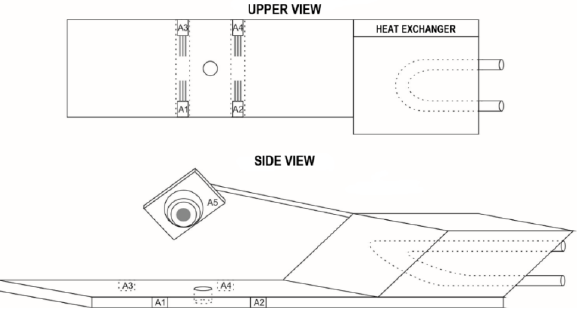
Figure 3. Schematic views of the hot-stage platform, where A1–A4 represent temperature sensors type LM35 and A5 represents the infrared thermometer type MLX90614.